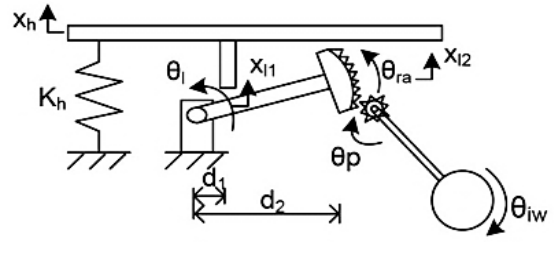
Figure 20. Lever system [43].